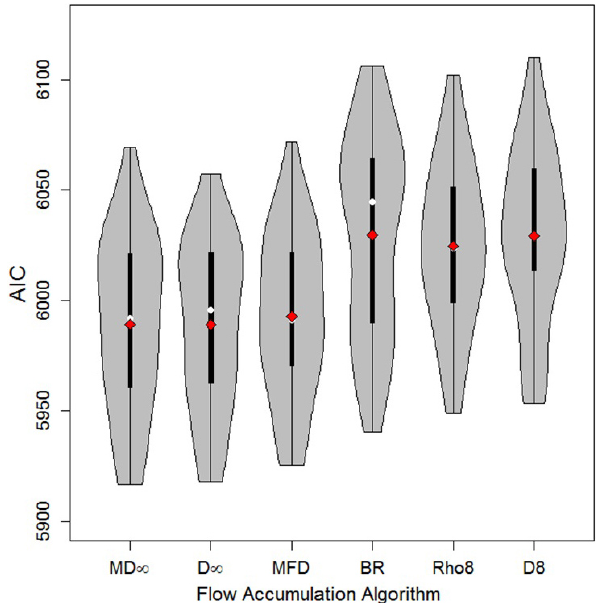
Figure 6. AIC distributions for each of the six test flow accumula- tion algorithms using lidar-derived DEMs. Mean and median values are depicted as red diamonds and white dots, respectively.